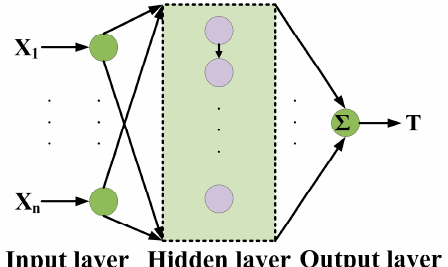
Figure 10. Basic structure of ANN.